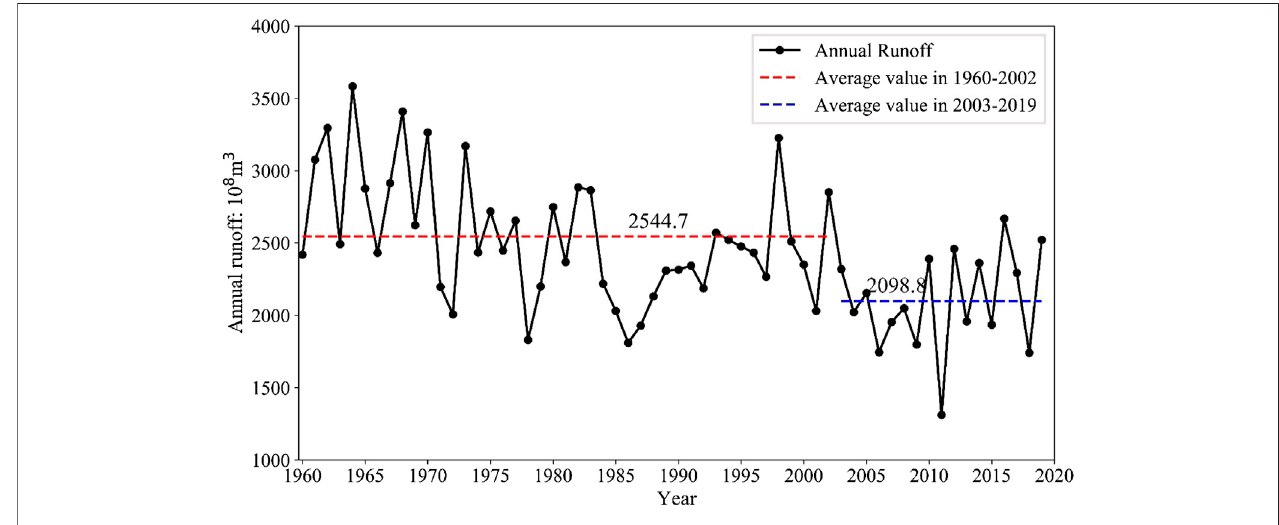
FIGURE 4 | Variations of annual in fl ow of Dongting Lake.